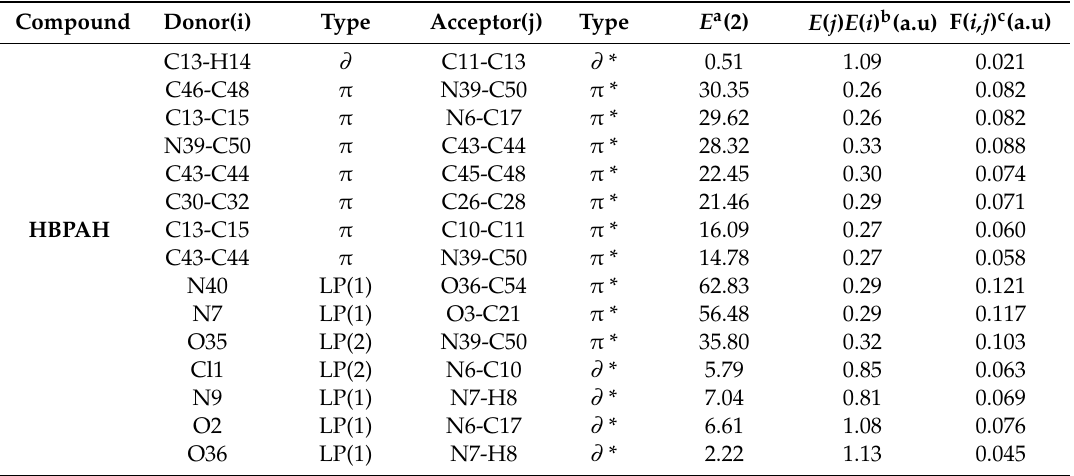
Table 5. Natural bonding orbital (NBO) analysis for HBPAH using the B3LYP / 6-311G(d,p) level.